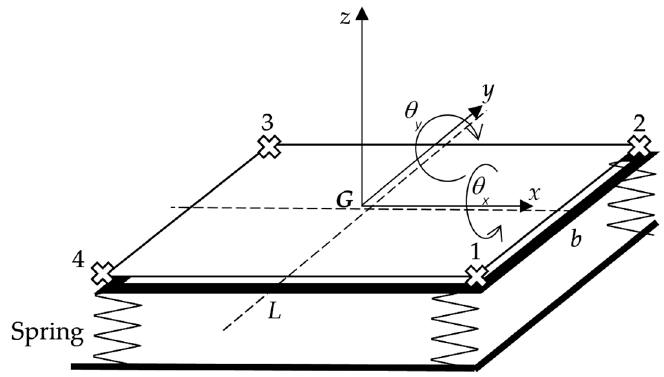
Figure 2. Platform model as a plane resting on 4 springs at corner nodes.